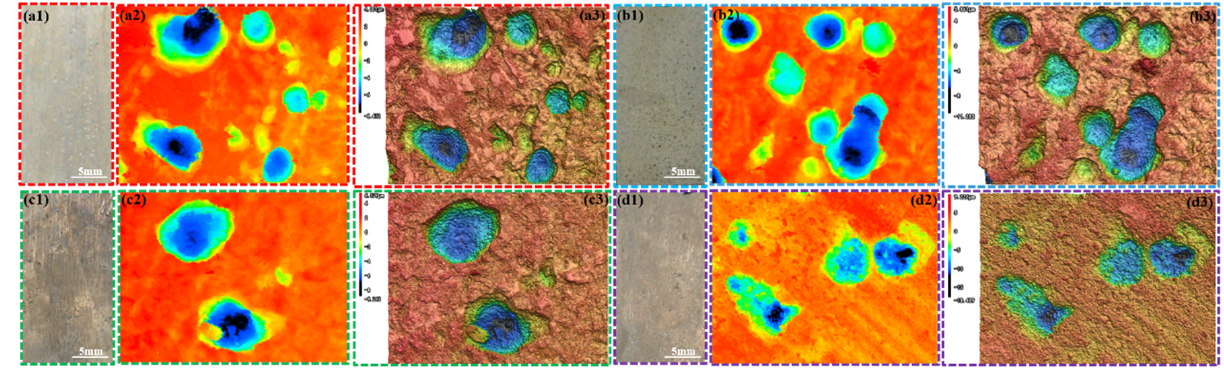
Figure 12. Surface and 3D morphology of T95 steel corroded in the liquid phase after cleaning the corrosion products (( a – d ) is 60 ◦ C, 90 ◦ C, 120 ◦ C, 150 ◦ C).